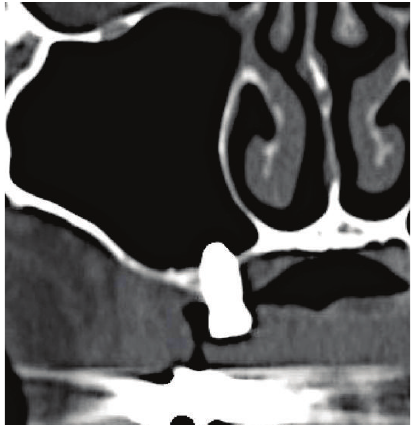
Figure 7: CT scan 8 months after sinus augmentation in the first stage showed that radiopacity around the implant increased.